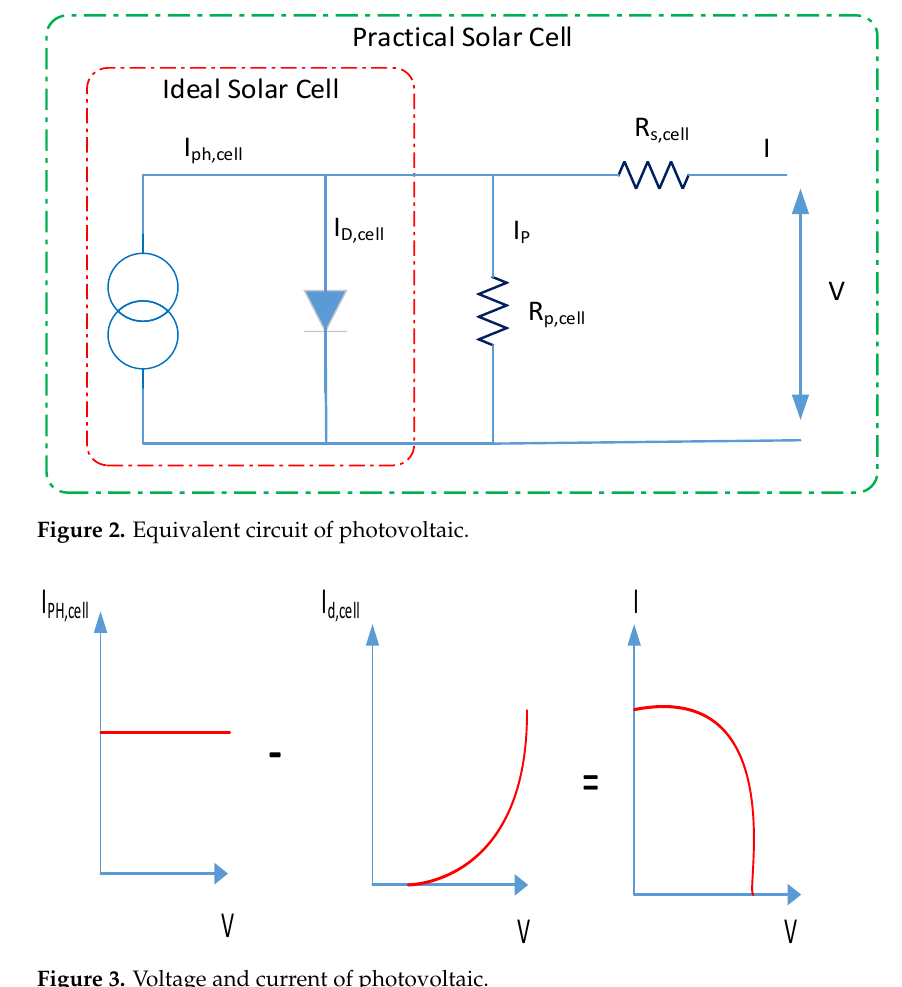
Figure 3. Voltage and current of photovoltaic.